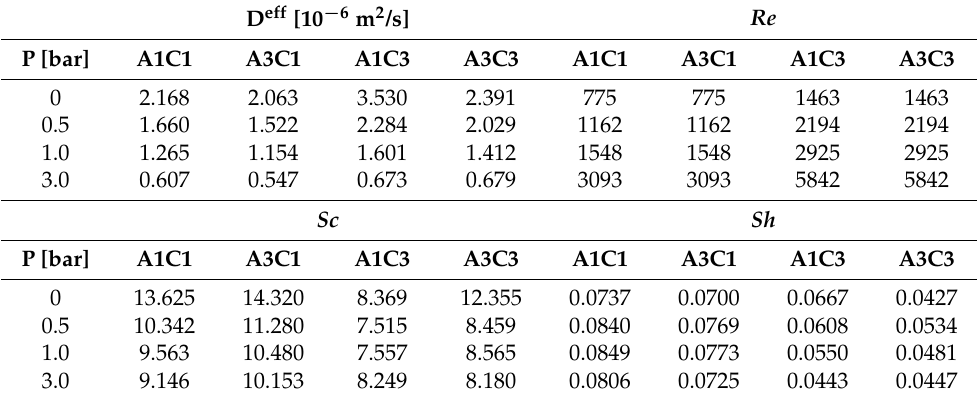
Figure 3. Performance comparison in ( a ) 0, ( b ) 0.5, ( c ) 1.0, and ( d ) 3.0 bar. Table 1. Effective reactant diffusivities and non-dimensional parameters ( Re , Sc , and Sh